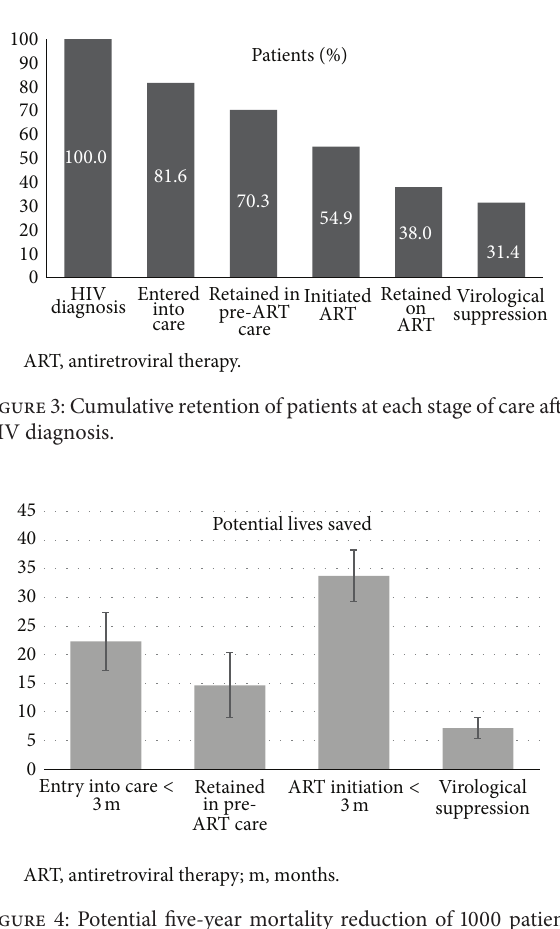
Figure 4: Potential five-year mortality reduction of 1000 patients diagnosed with HIV infection (error bars = standard errors).